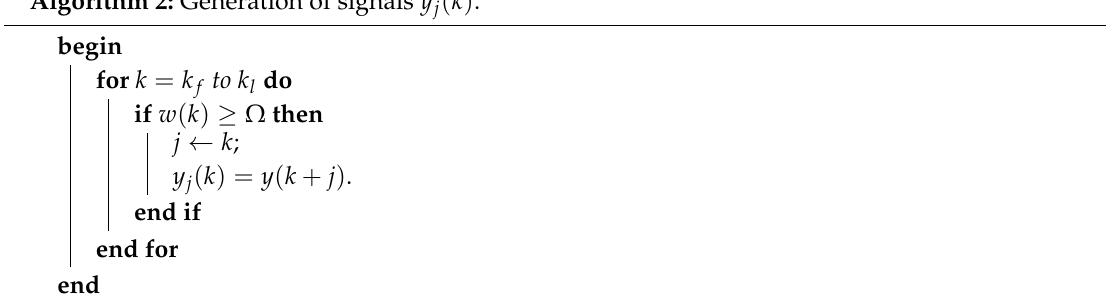
Algorithm 2: Generation of signals y j ( k )